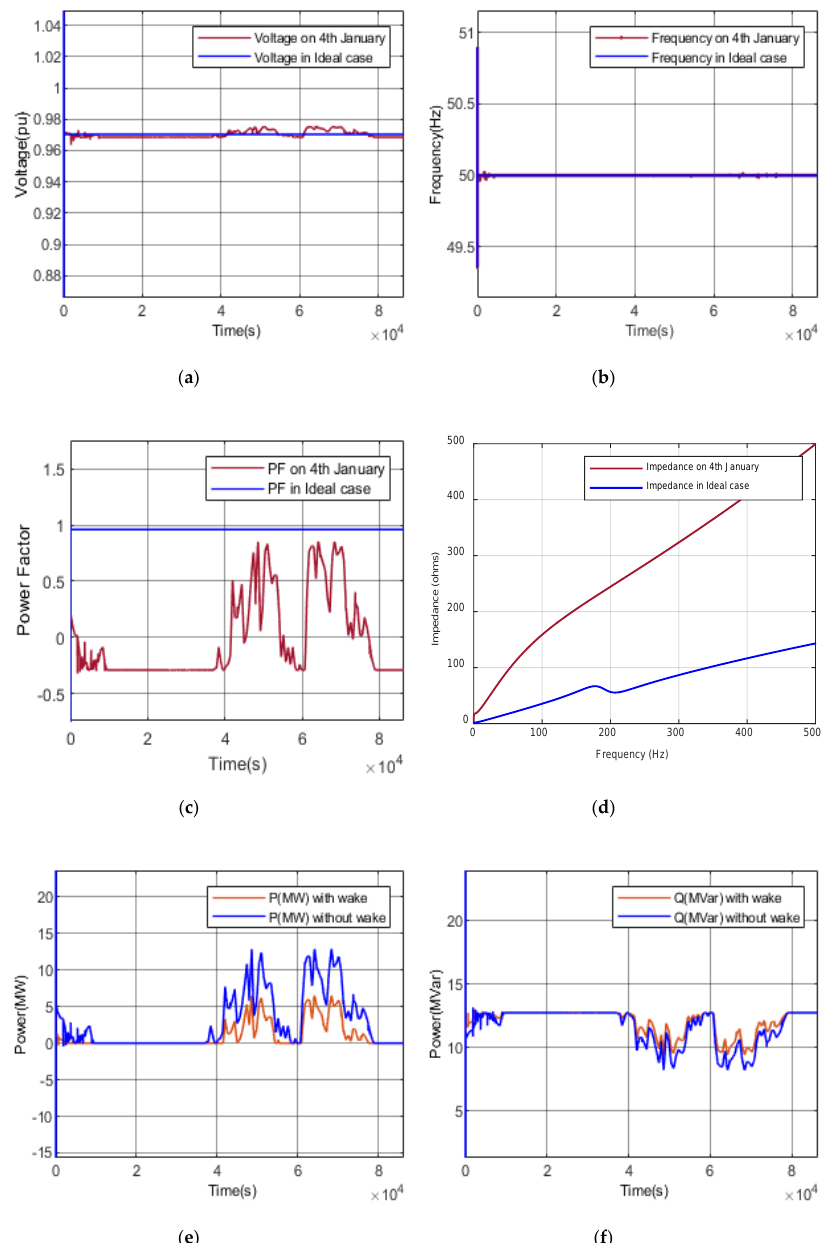
Figure 5. Case-1, Scenario 2: ( a ) Voltage (V) at PCC; ( b ) frequency (F) at PCC; ( c ) PF at PCC; ( d ) impedance (Z) vs. F; ( e ) P-trend; and ( f )